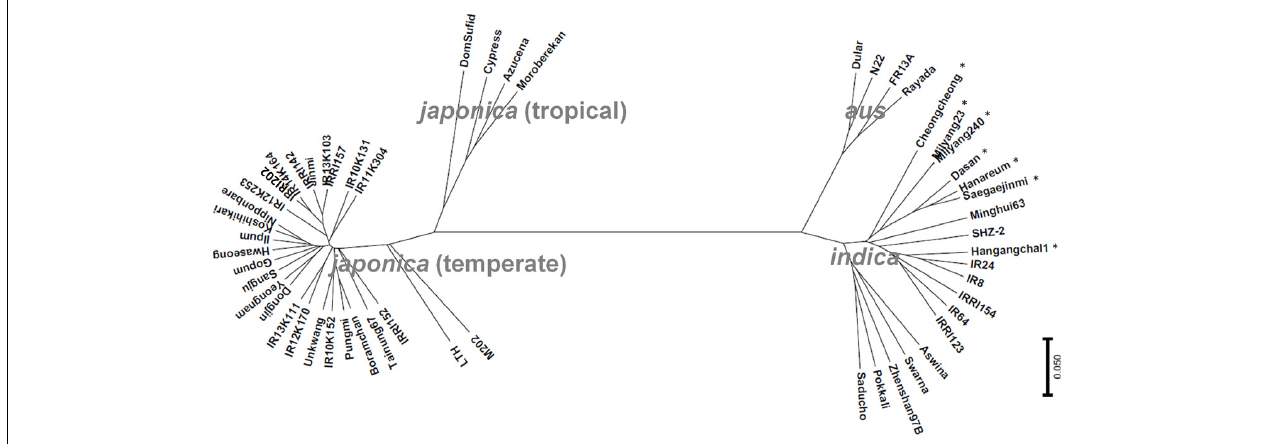
FIGURE 6 | Phylogenetic analysis. All materials, except for three accessions (Kitaake, Taichung 65, and Kasalath), were analyzed by 6K SNP chip and the phylogenetic tree was constructed by using 2,918 SNP data points. The samples were grouped into aus , indica , tropical japonica , and temperate japonica types consistent with the previous report (McNally et al., 2009). Asterisk ( ∗ ) refers to Tongil-type rice